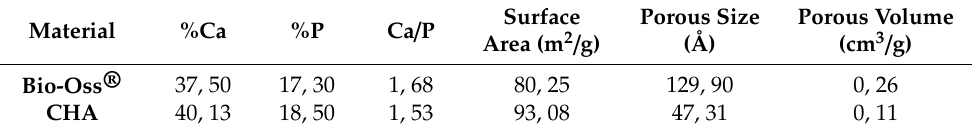
Table 1. Percentage and Ca / P ratio, data on surface area, pore size, and pore volume.